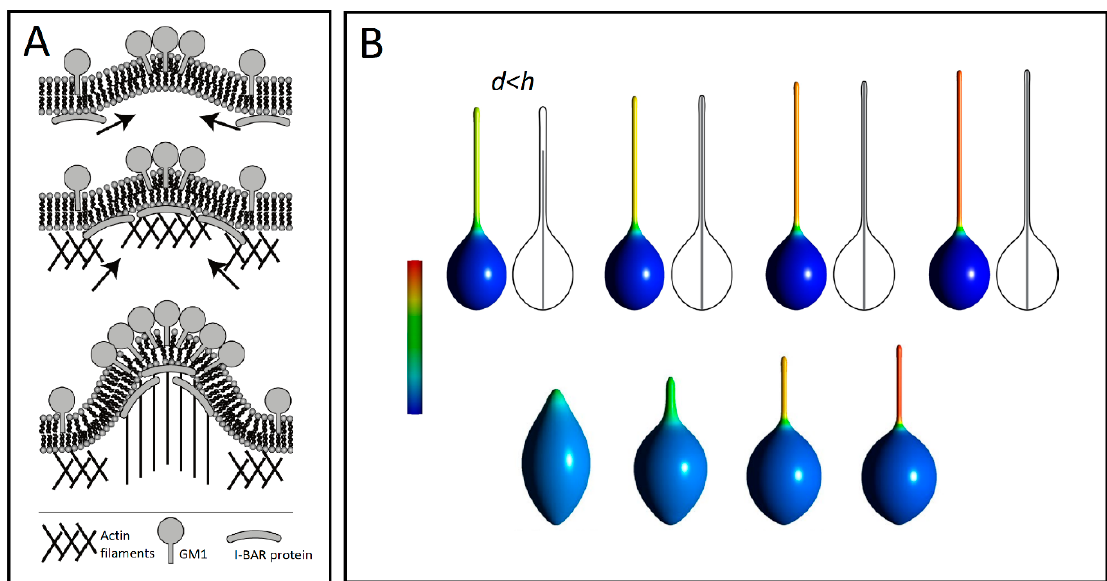
Figure 5. ( A ) A schematic diagram for the recruitment of I-BAR domain proteins and actin filaments by GM1 aggregates (adapted from Reference [10]). ( B ) Numerically calculated equilibrium cell shapes for different lengths d of the actin rod-like structure enclosed inside the vesicle of height h . All vesicles have the same relative volume (0.9). Apart from the top-left vesicle shape, d = h . The mixing entropy term was considered only for the second row. The color represents the fraction area covered by isotropic components. The fully blue color corresponds to a membrane composed of isotropic nanodomains only, while the yellow and red colors denote high concentrations of anisotropic components (adapted from Reference [92]).